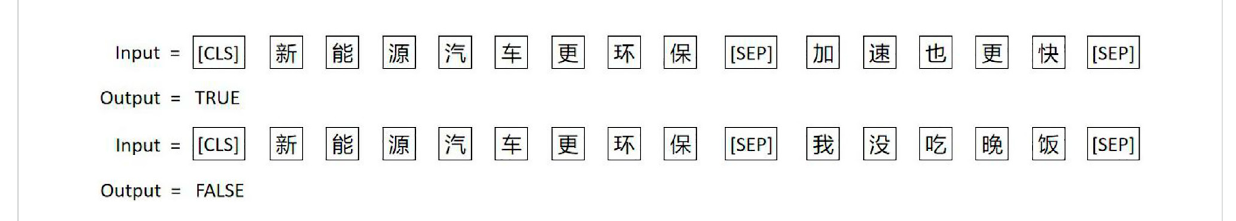
FIGURE 5 Next sentence prediction